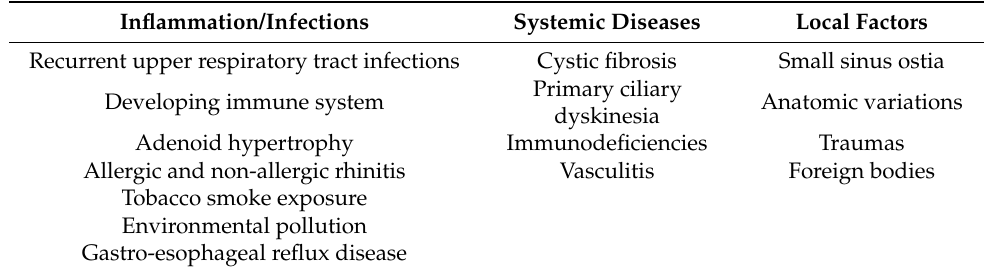
Table 2. Potential and well-known risk factors for CRS in childhood. Inflammation/Infections Systemic Diseases Local Factors Recurrent upper respiratory tract infections Cystic fibrosis Small sinus ostia Primary Developing immune system